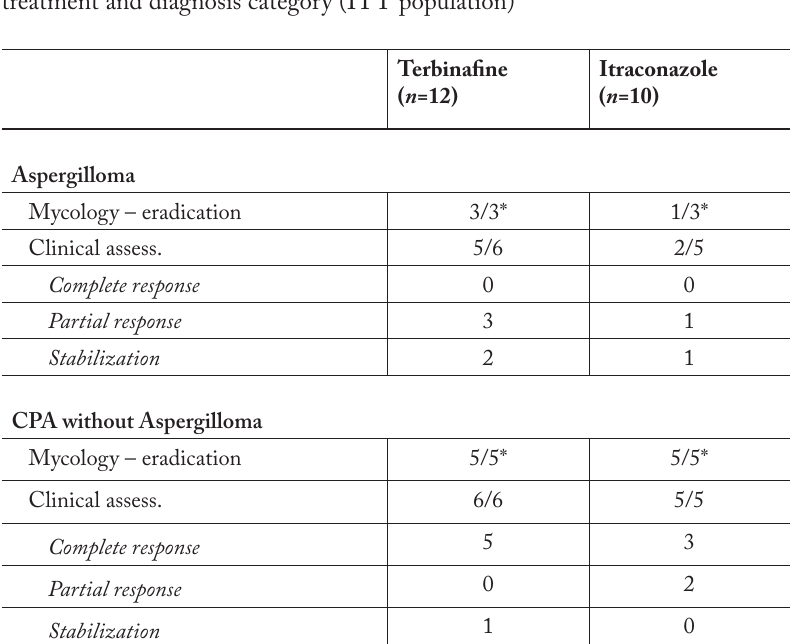
Table 1. Positive Mycological results and positive clinical assessments by treatment and diagnosis category (ITT population)